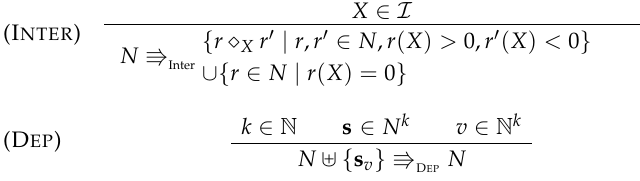
Figure 6. Simplification of reaction networks without kinetics with respect to a set I of intermediate species.